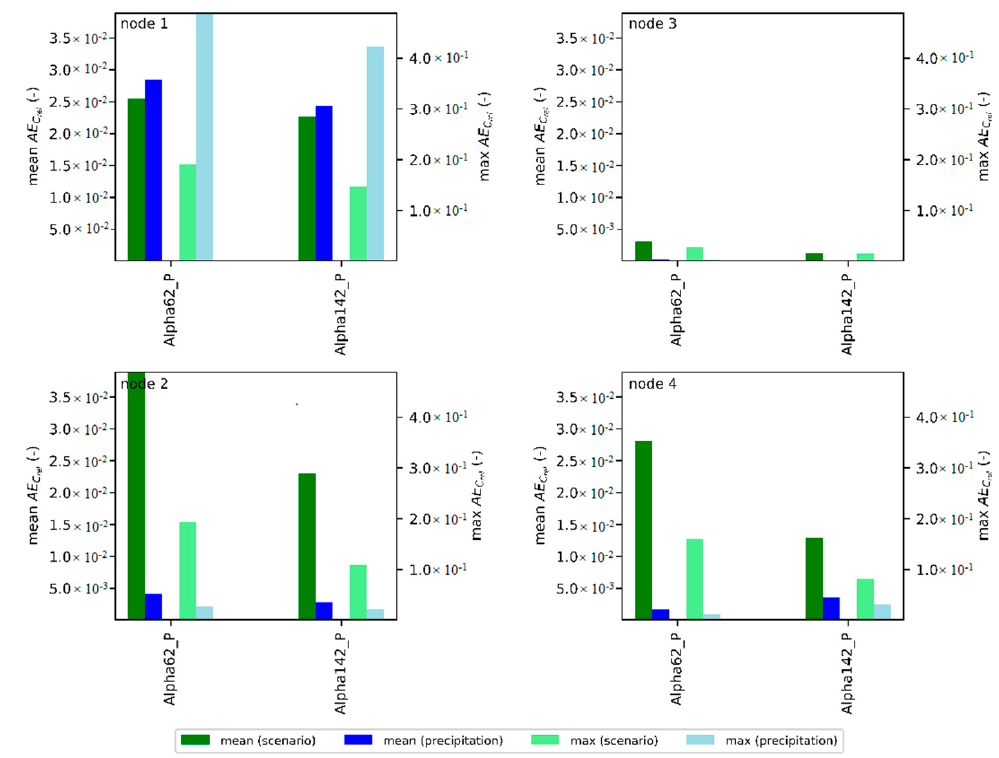
Figure 7. Mean ( mean AE Crel ) and maximum absolute errors ( max AE Crel ) representing scenario (green) and precipitation (blue) sensitivities at four selected observation nodes for the scenario under variation of the van Genuchten shape parameter α . _P has been generally added to scenario abbreviations.